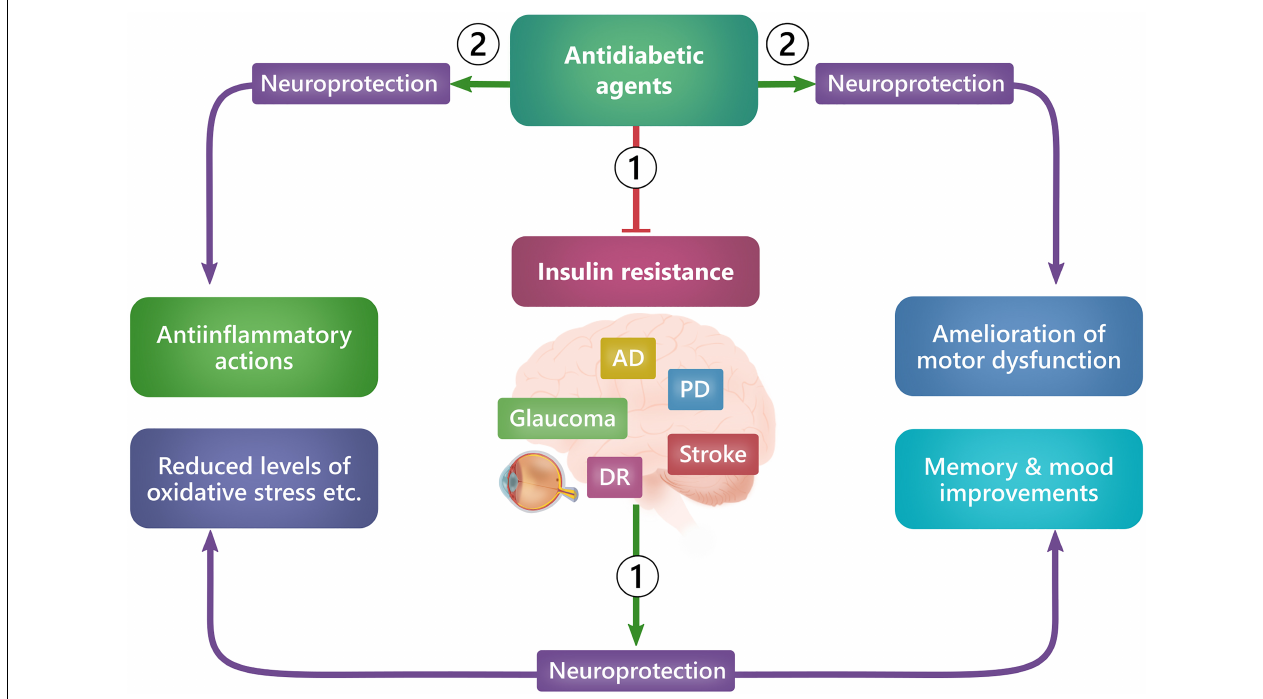
FIGURE 3 | Ways in which GLP-1R agonists exert neuroprotection. GLP-1R agonists can exert neuroprotection either systemically (1), by improving glycemic control and reducing insulin resistance, or locally (2), by acting on receptors in neuronal tissue cells and thus causing, e.g., antiinflammation, preservation of memory, dopaminergic neurons, motor function and mood improvements. AD: Alzheimer’s disease, DR: Diabetic retinopathy, PD: Parkinson’s disease